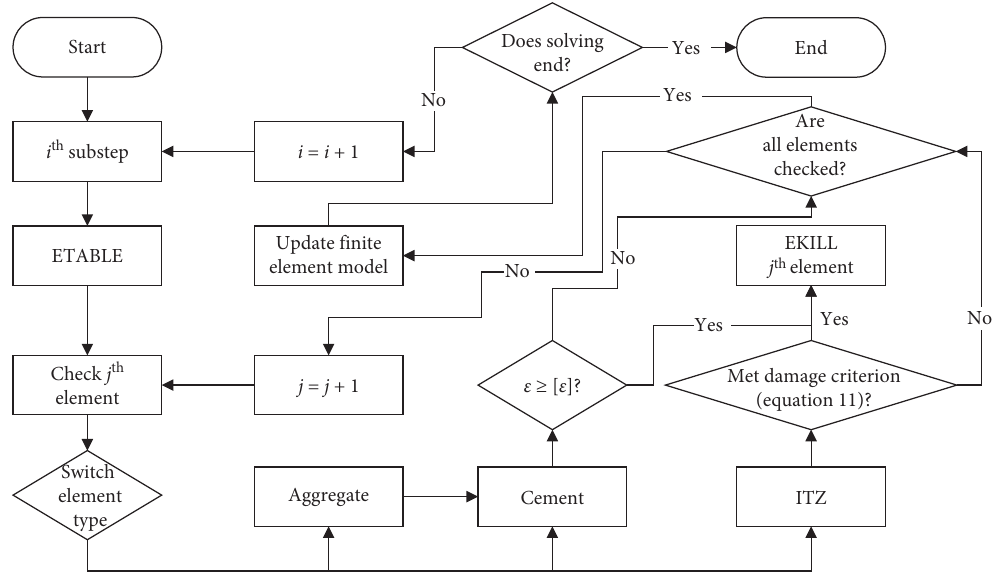
Figure 1: Schematic diagram of the algorithm for solving the finite element model. Table 1: Sieving test results for the concrete prism